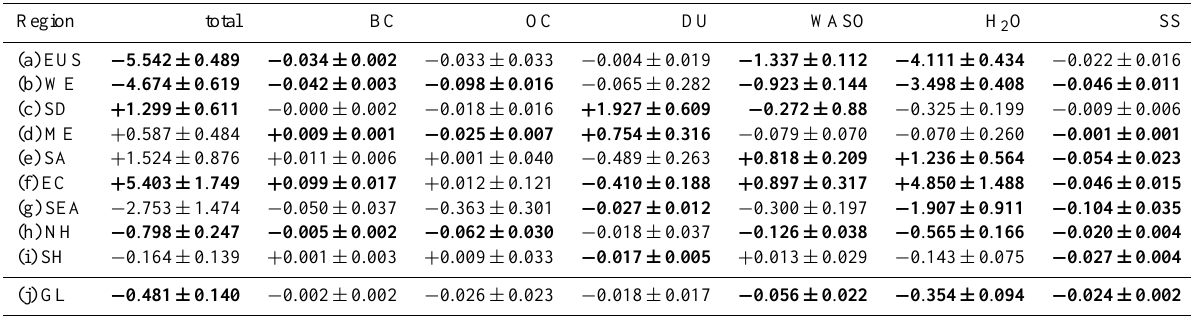
Table 1. Regional trend estimates of BASE-based AODs, i.e., total, black carbon (BC), organic carbon (OC), dust (DU), water soluble (WASO), H 2 O, and sea salt AODs, in 10 − 3 year − 1 . One standard deviation is also shown. Bold type indicates the significant trend within 95% of confidence